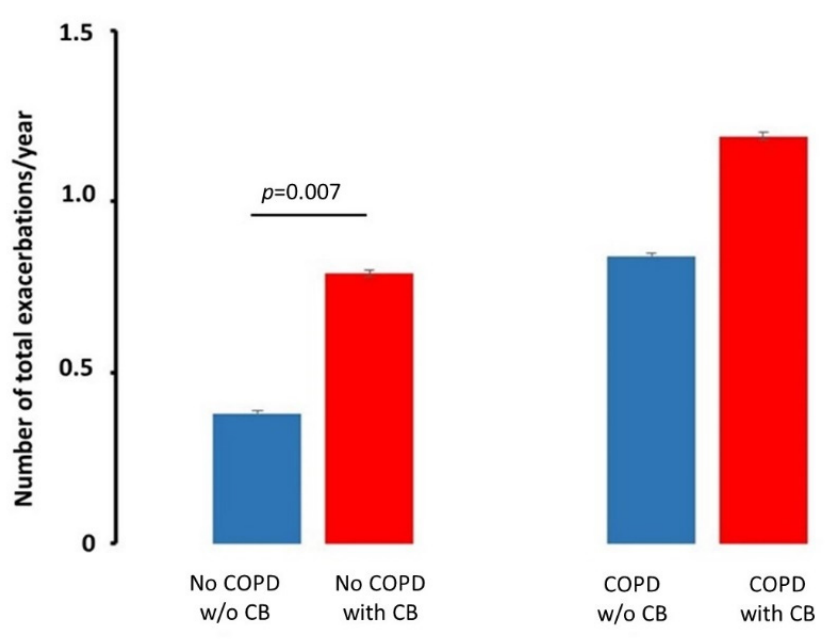
Figure 3. Effects of Chronic Bronchitis (CB) on the number of total exacerbations per year. The presence of CB worsens the total number of exacerbations in smokers without COPD but not in those with COPD. Histograms represent mean ± SD. COPD: Chronic Obstructive Pulmonary Disease.